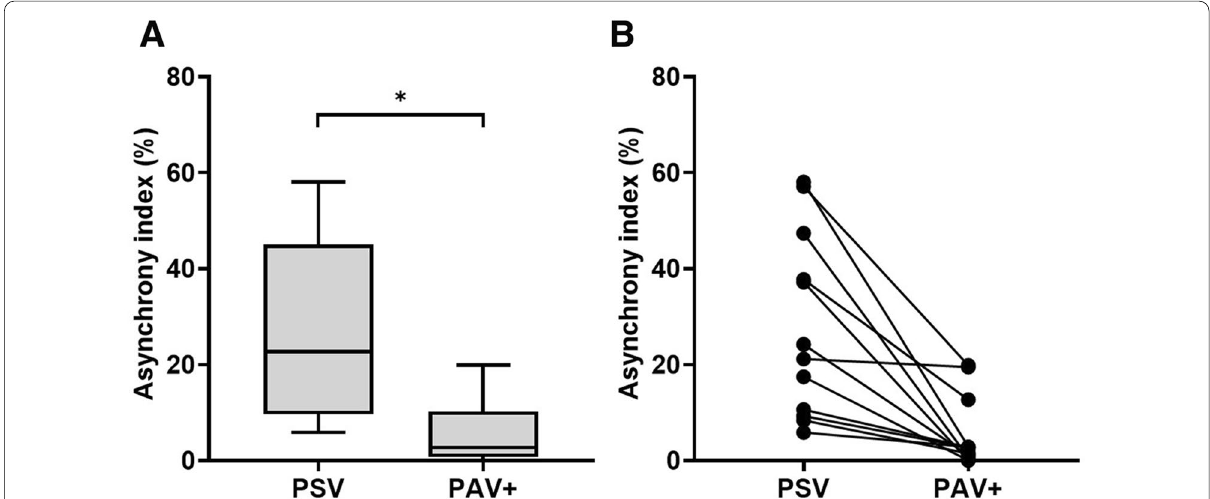
Fig. 2 Asynchrony index under PSV and PAV . Physiological study. Asynchrony index, defined as ineffective efforts/(effective efforts + efforts) under pressure support ventilation (PSV) with the lowest tolerated pressure support level and proportional assist ventilation with load‑adjustable gain factors (PAV ) with the gain adjusted to target a peak muscle pressure between 5 and 10 cmH 2 O. A The box plots represent + the asynchrony index (thick horizontal bar: median; extremities of the boxes: 25th and 75th percentiles; thin horizontal bars: fifth and 95th percentiles). * Denotes statistical significance. B Individual